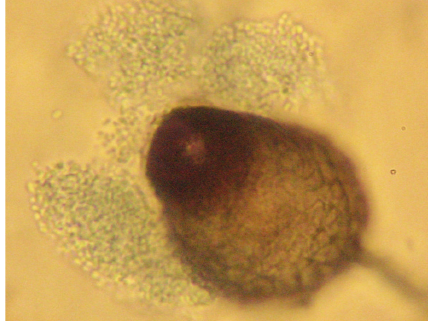
Figure 17: Histoplasma capsulatum tan colored colony after 20 days of incubation in Sabouraud-Emmons agar obtained from sclera sample